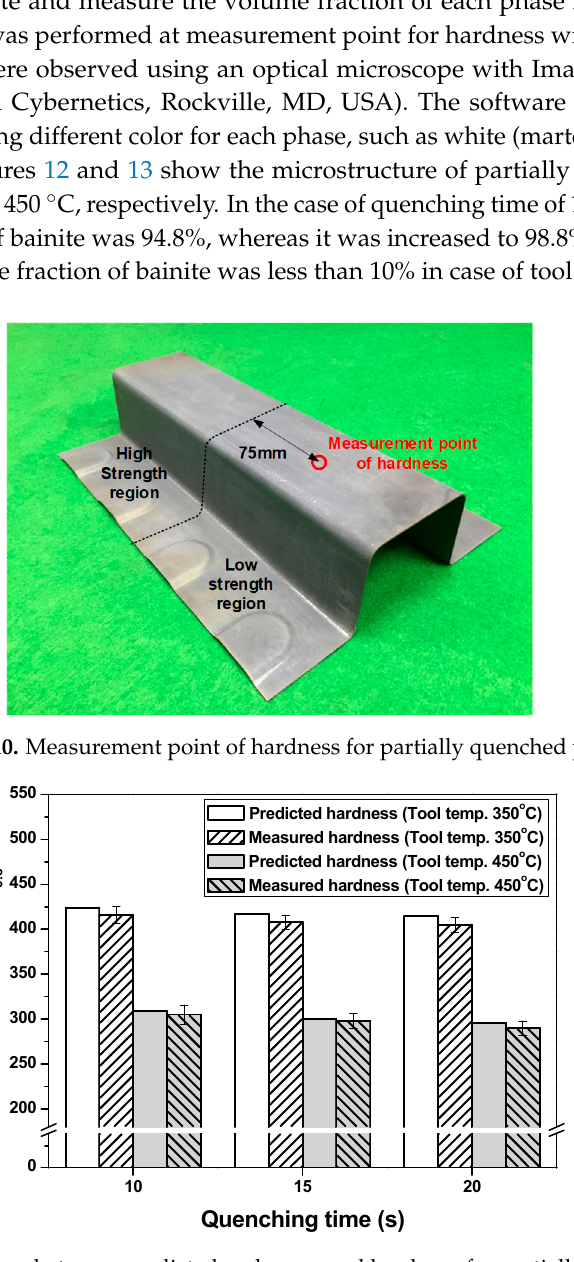
Figure 11. Comparison between predicted and measured hardness for partially quenched part.